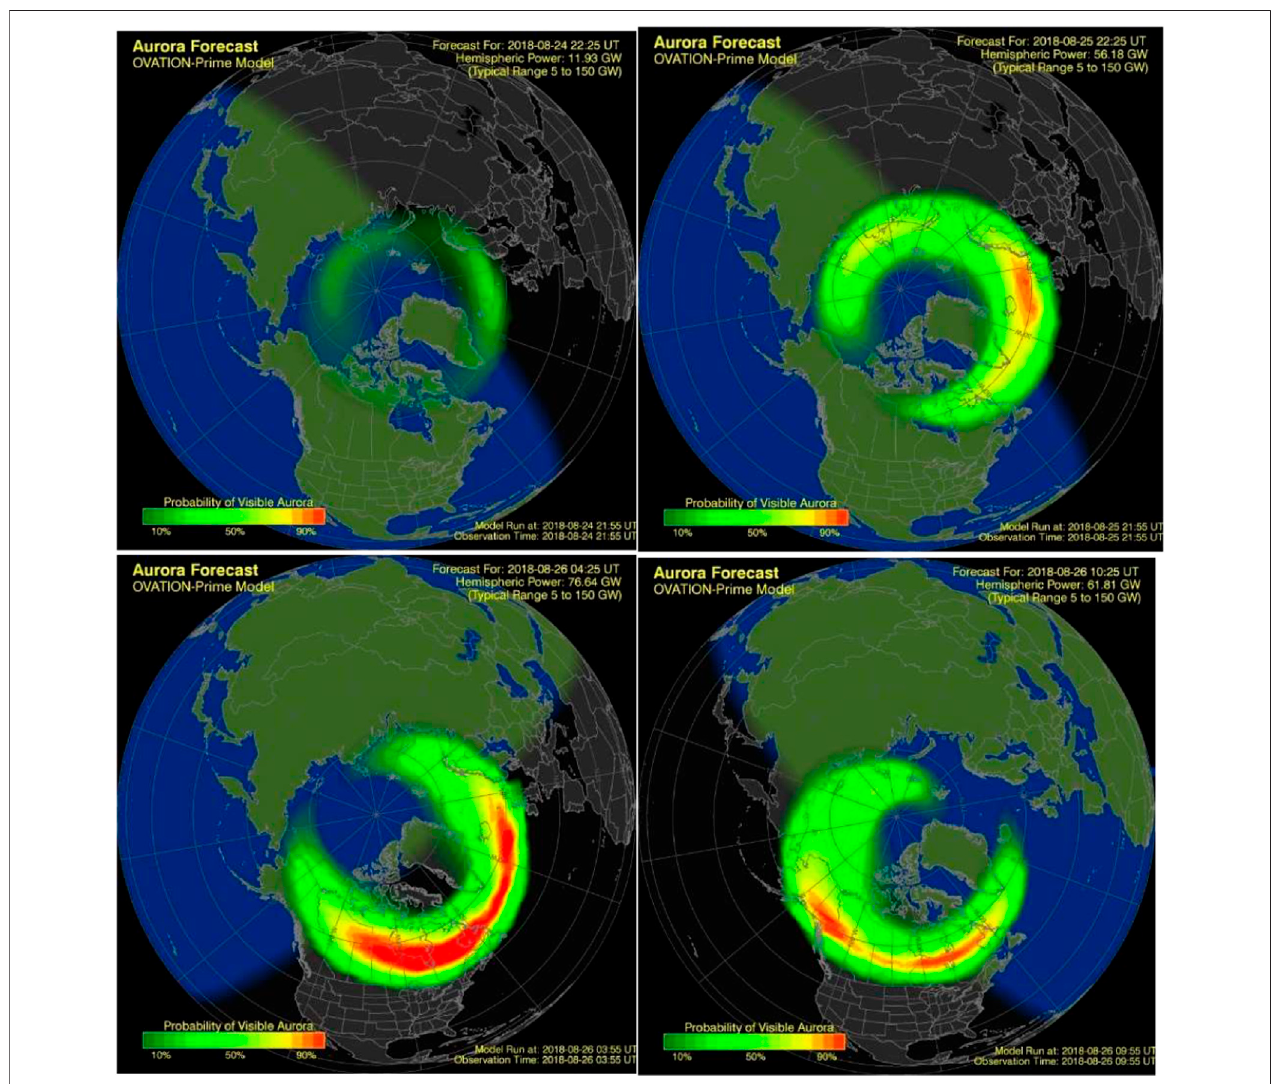
FIGURE 15 | Northern hemisphere probability of aurora visibility as predicted by the OVATION model before the storm (upper left) on 24-8-2018 at 22h25, and then during the storm on (upper right) 25-8-2018 at 22h25, on (bottom left) 26-8-2018 at 4h25 and on (bottom right) 26-8-2018 at 10h25. Greenwich longitude of 0 ° is located in the right side of the